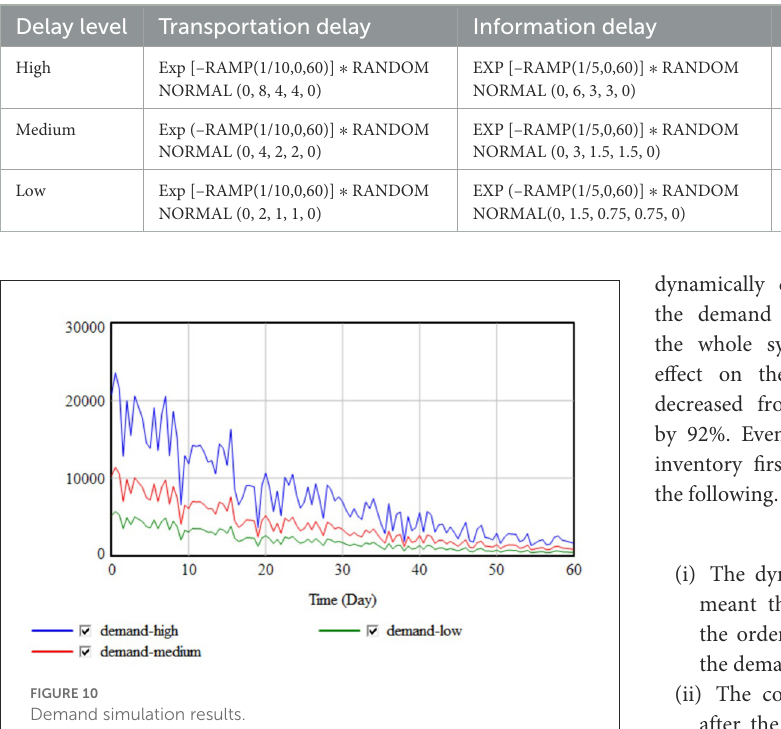
stable. Compared to the case without white noise (SS01), the total inventory means and variance, respectively increased by 5 and